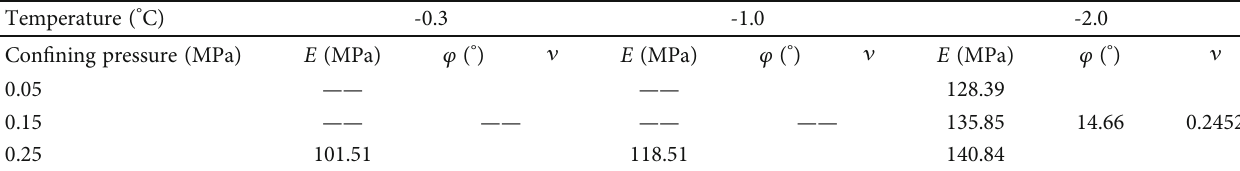
Figure 2: Triaxial compression test stress-strain curve of frozen sand. Table 2: Basic mechanical parameters of the model.